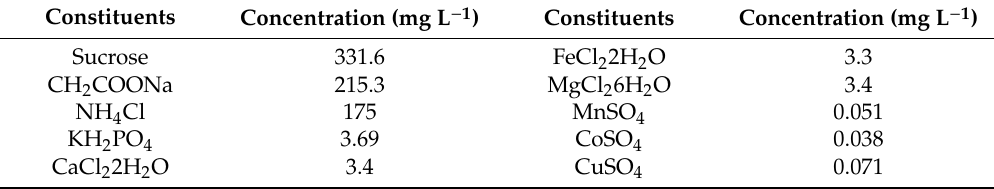
Table 1. Constituents of the synthetic wastewater solution added to the sequencing batch